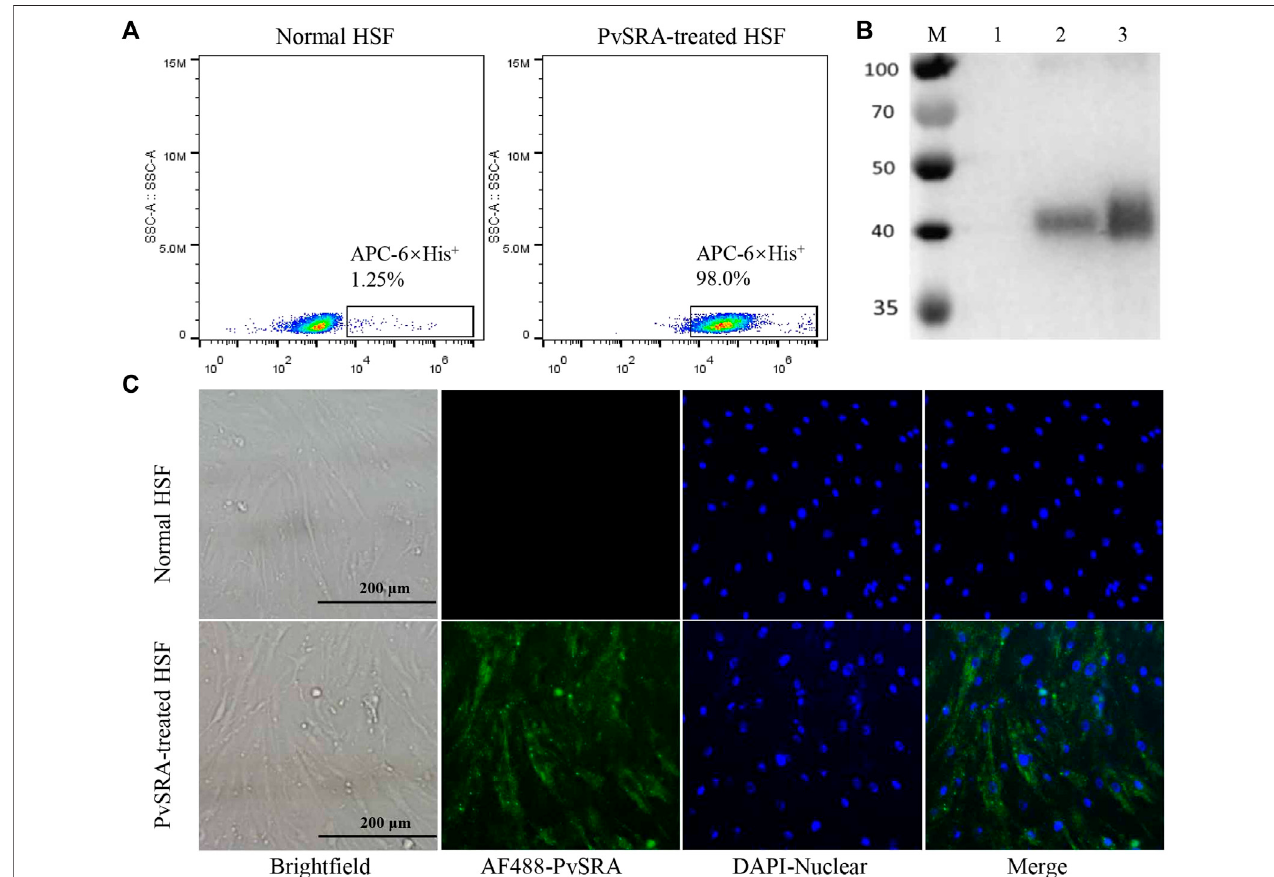
FIGURE 2 | Binding of PvSRA with HSF. The binding of the recombinant PvSRA protein and HSF was detected by using anti-6 × His tag antibody in the following tests. (A) FACS was applied to test the binding capacity of PvSRA on HSF membrane surface. (B) WB analysis of the binding capacity of PvSRA with HSF. M: Protein marker; lane 1: normal HSF lysate; lane 2: PvSRA treated HSF lysate; lane 3: recombinant PvSRA control-sample. (C) Immuno fl uorescence was applied to test the binding between PvSRA and HSF by using anti-6 × His tag antibody and Alex Flour 488- conjugated goat anti-rabbit IgG. Nuclei are visualized with DAPI in merged images. Bars represent 200 μ